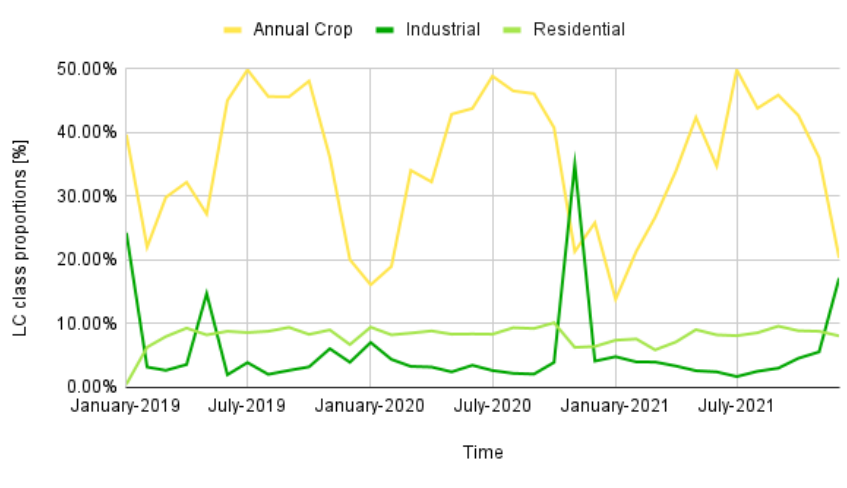
Figure 9. Distribution of indicator classes for